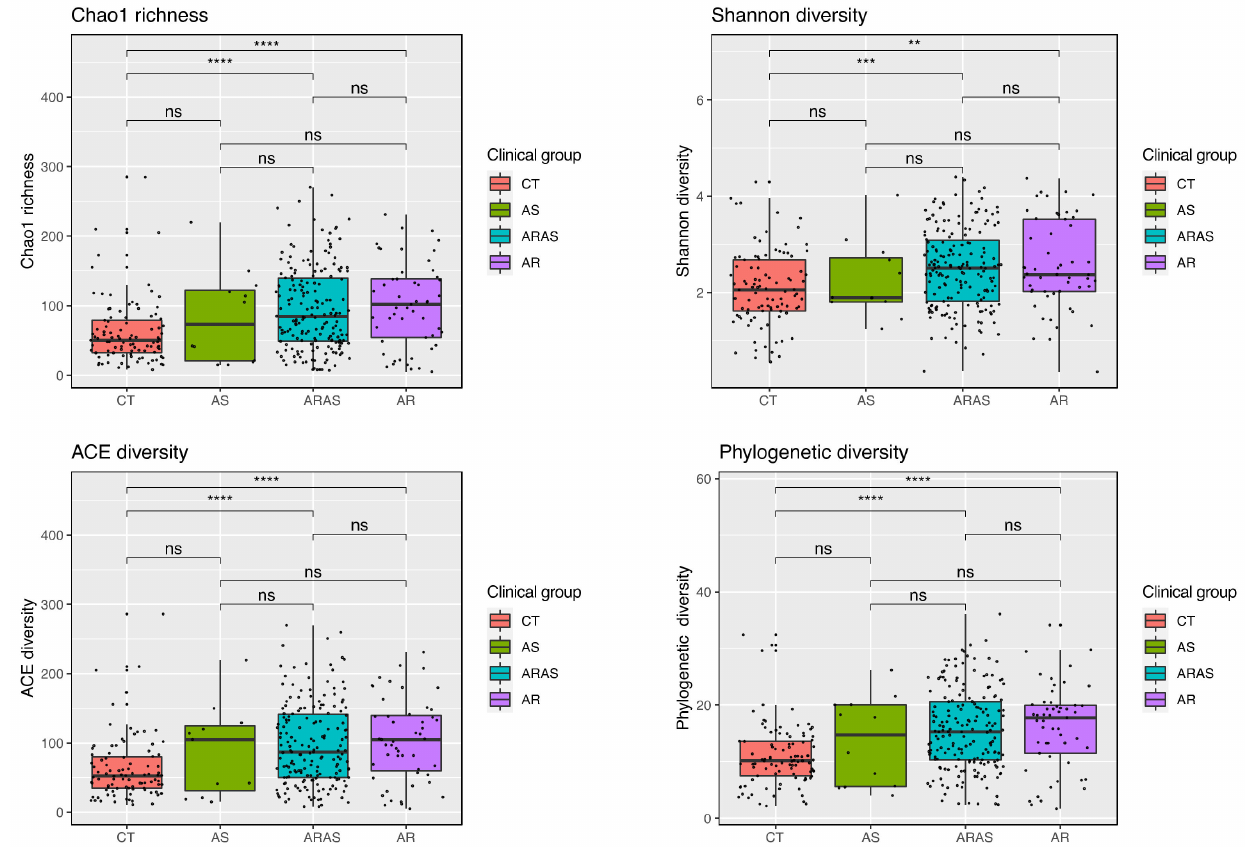
Figure 2. Alpha-diversity estimates (Chao1, Shannon, ACE, and phylogenetic diversity) of nasal bacterial diversity and statistical significance (Wilcoxon test) in participants with asthma (AS), allergic rhinitis with comorbid asthma (ARAS), allergic rhinitis (AR) and healthy controls (CT). ns = not significant; ** = p ≤ 0.01; *** = p ≤ 0.001; **** = p ≤